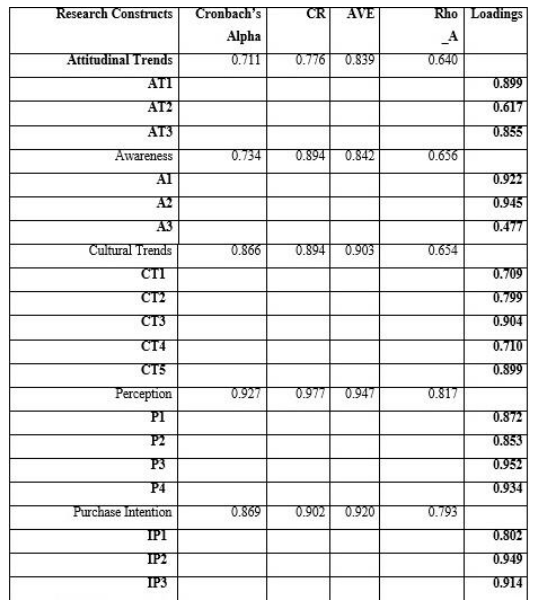
Table 2: Reliability and Validity Factor Loadings